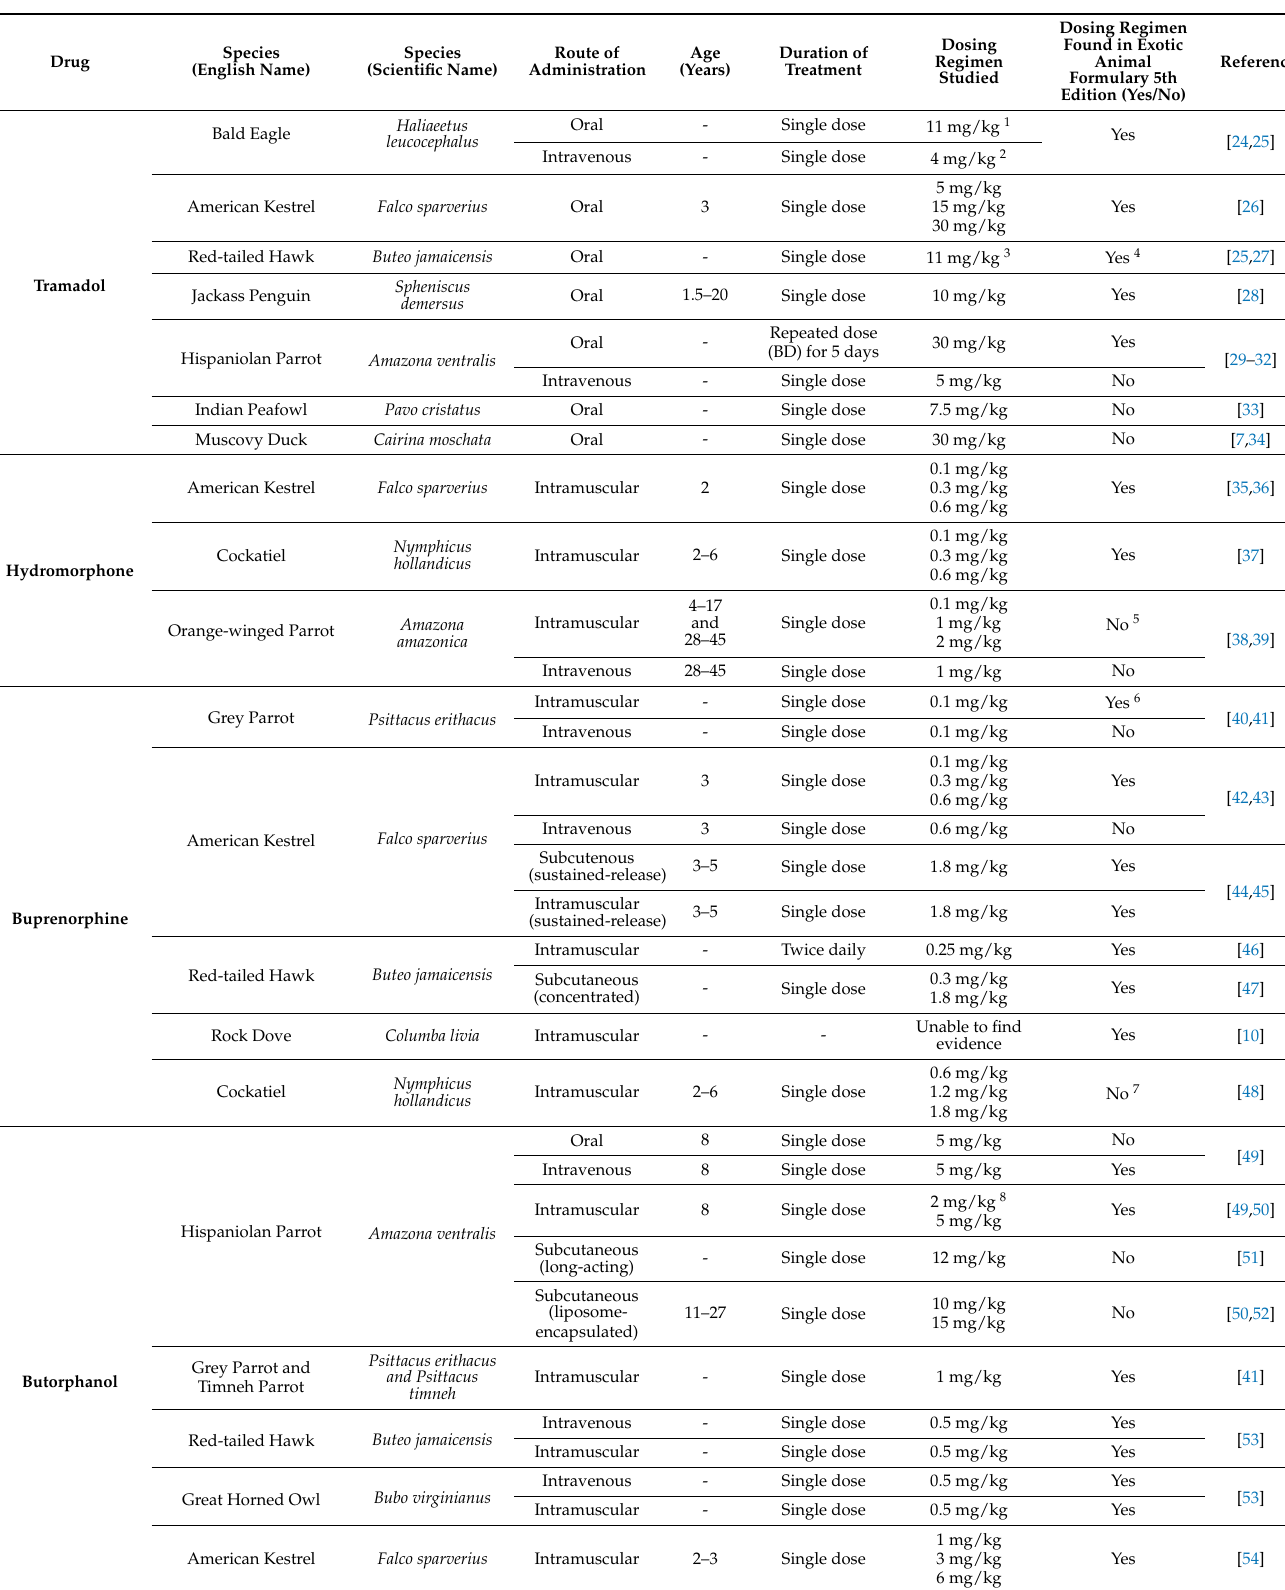
Table 2. Dosing regimens of selected opioids studied in various species of